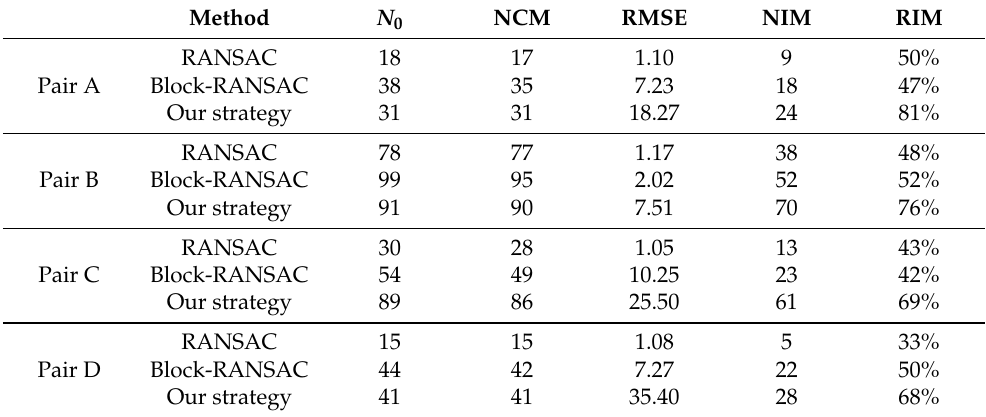
Figure 16. Details of image transformation relationships detected by RANSAC, Block-RANSAC and the proposed strategy in pair A. Table 4. Registration results for all the test sets.